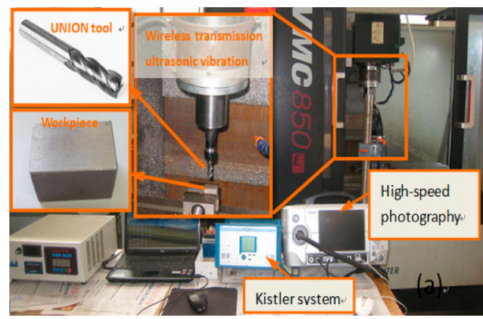
Figure 8. Experimental